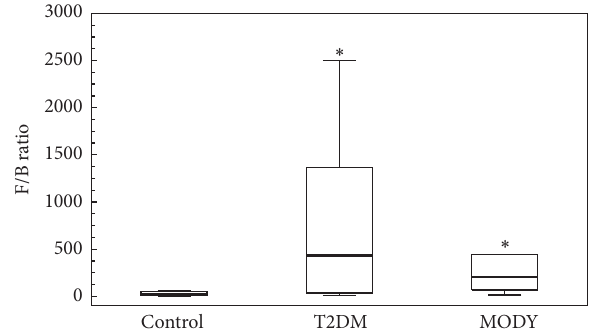
Figure 3: Box plots presenting the Firmicutes/Bacteroidetes ratio comparison between groups. The Firmicutes/Bacteroidetes (F/B) ratio was significantly higher in both T2DM ( 𝑝 = 0.0005 ) and HNF1A-MODY ( 𝑝 = 0.0113 ) groups than in the control group. There was no difference between T2DM and HNF1A-MODY groups. To show differences in F/B ratio, the Kruskal-Wallis test was performed. ∗ indicates that there was a significant difference between this group and control